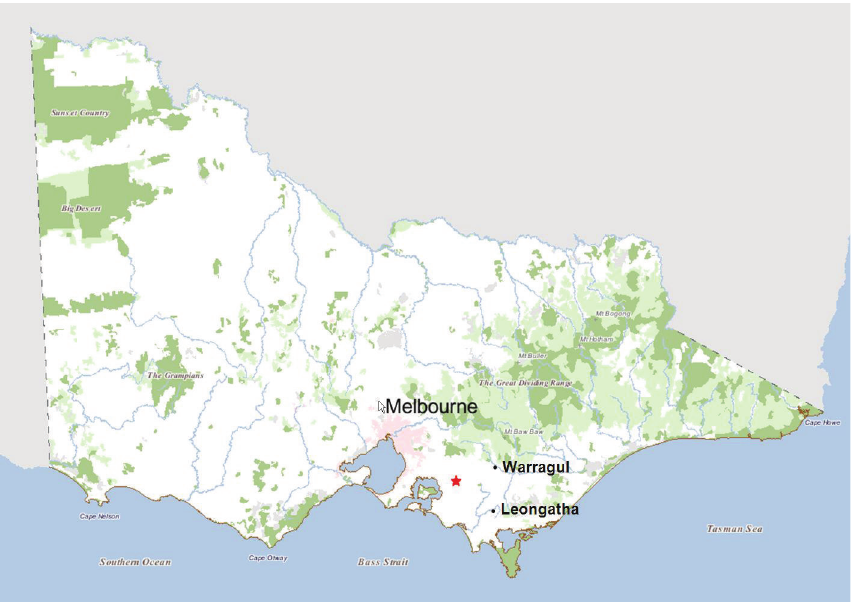
Figure 1: Location of the experimental site at Poowong, VIC,